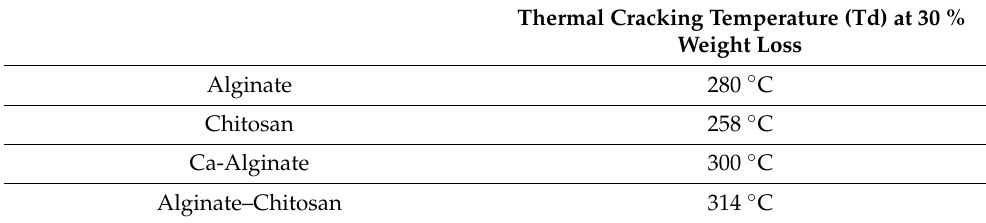
Table 4. Thermal cracking temperature (Td) of TGA spectrum.